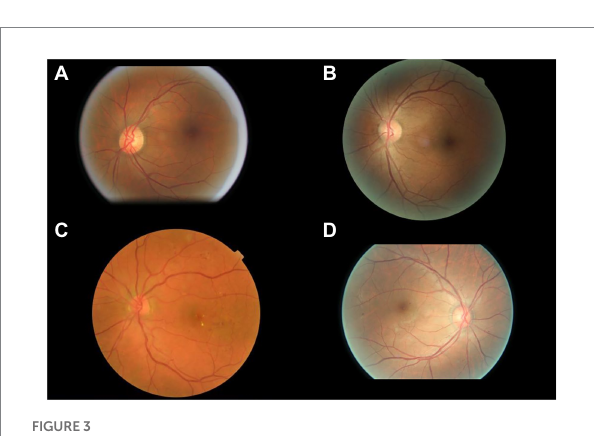
FIGURE 3 Sample images consistently misclassified by human participants. (A,B) Images with only microaneurysm misclassified as referable diabetic retinopathy. (C) Images of diabetic macular